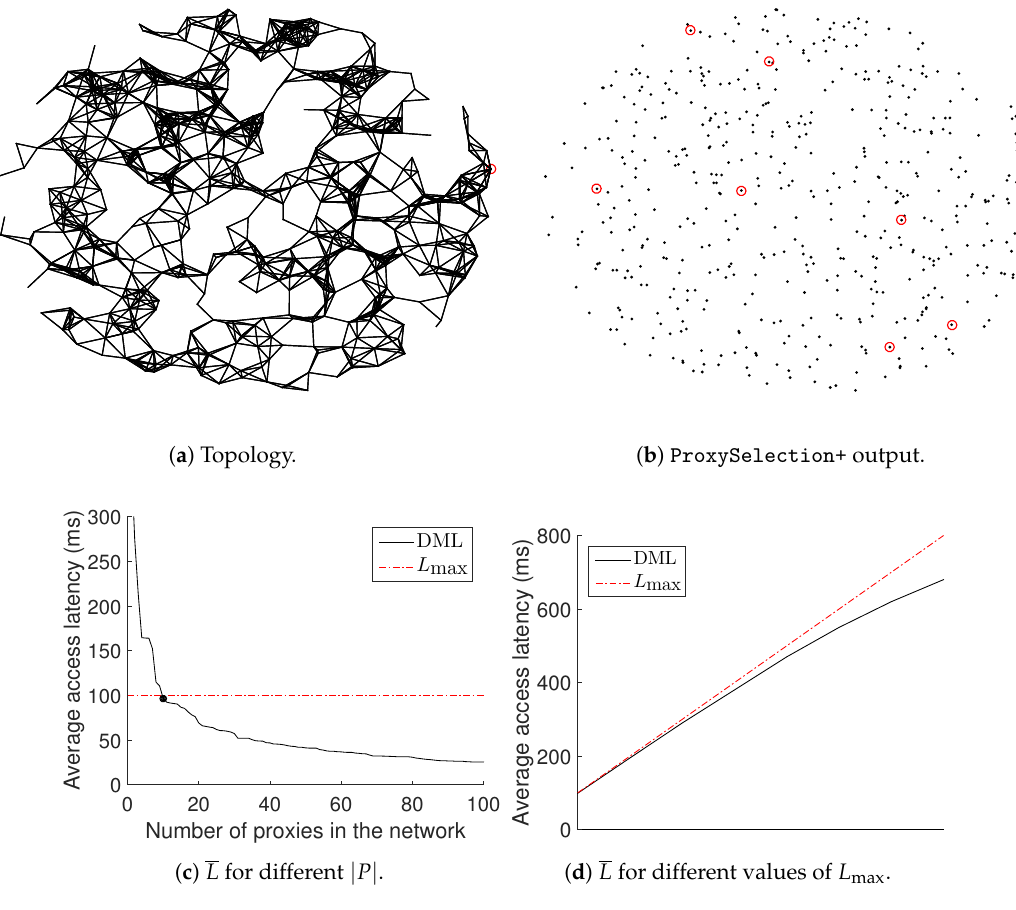
Figure 7. Network with n = 500, m = 0.4 · | S |